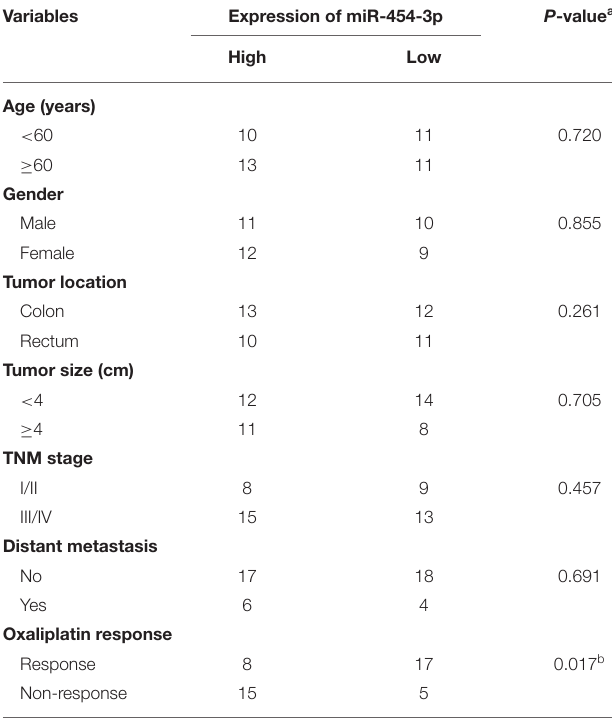
TABLE 1 | Associations between miR-454-3p levels and clinicopathological